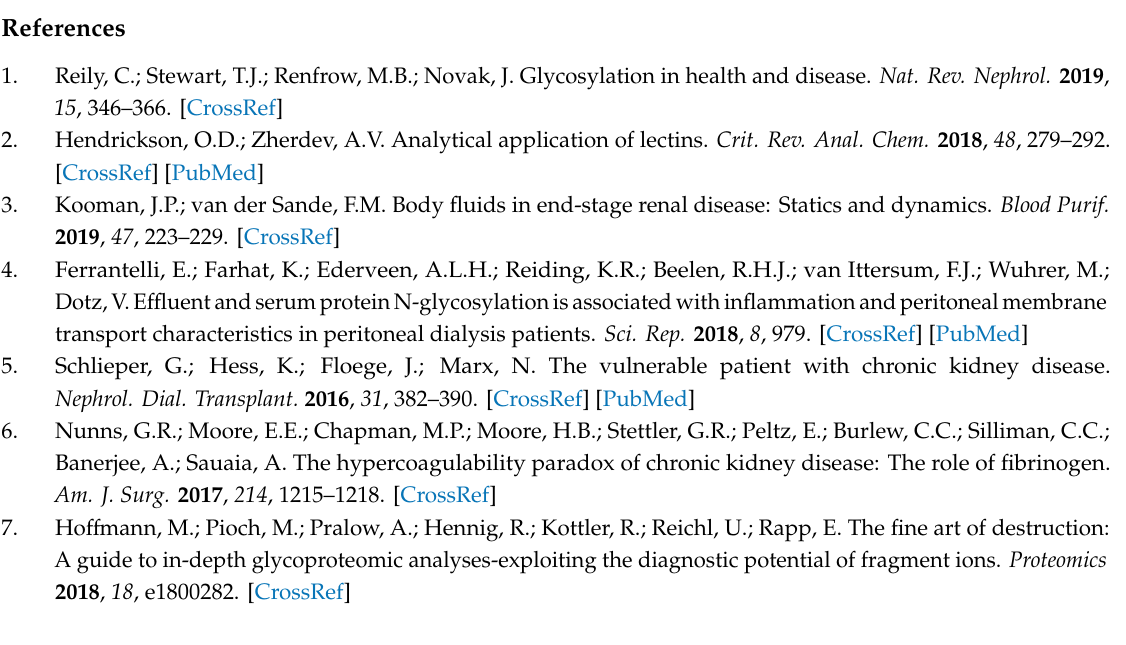
Figure S1: Structures of N- and O-glycans mentioned in the manuscript, with the carbohydrates annotation according to the recommendations of the Consortium for Functional Glycomics